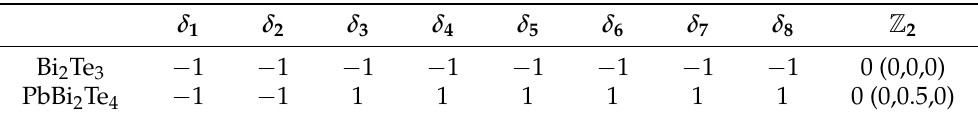
Table 2. δ i values at eight time-reversal invariant momenta and Z 2 invariant values of Bi 2 Te 3 under − 8.4% strain and PbBi − 2.2% strain. 2 Te 4 under